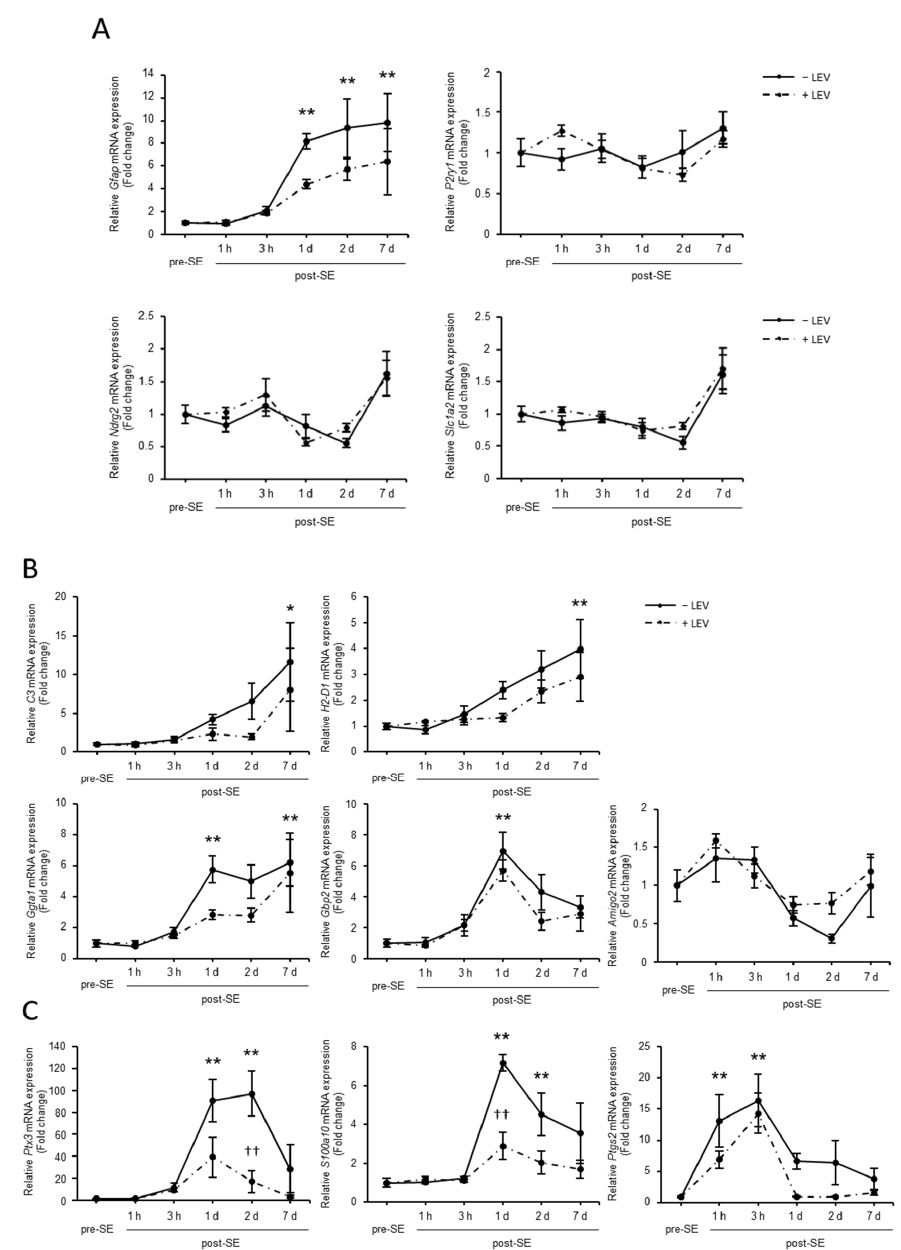
Figure 6. Effect of PILO-SE and LEV administration on the transformation of A1/A2 reactive astro- cytes. Time-course real-time PCR analysis of A1-specific mRNA expression during epileptogenesis. Total RNA was extracted from the hippocampi of mice treated with LEV or that were untreated before (pre-) and after (post-) SE at 1 h, 3 h, 1 day, 2 days and 7 days. The mRNA expression levels of astrocytic markers ( Gfap , P2ry1 , Ndrg2 and Slc1a2 ) ( A ), A1-specific markers ( C3 , H2-D1 , Ggta1 , Gbp2 and Amigo2 ) ( B ) and A2-specific markers ( Ptx3 , S100a10 and Ptgs2 ) ( C ) during epileptogenesis were assessed using real-time PCR. The values were normalized relative to the β -actin ( Actb ) mRNA level and then divided by those of the control group (pre-SE) to calculate the relative mRNA levels. All data points represent the mean ± SEM of at least three independent experiments ( n = 3–9). Data were analyzed for significant differences by one-way ANOVA and Tukey’s post-hoc test. Results with p values < 0.05 were considered statistically significant. ** p < 0.01, * p < 0.05 vs. pre-SE mice, †† p < 0.01 vs. without post-SE